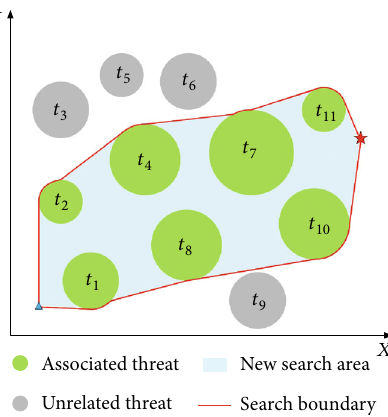
Figure 16: Diagram of new spatial search area.